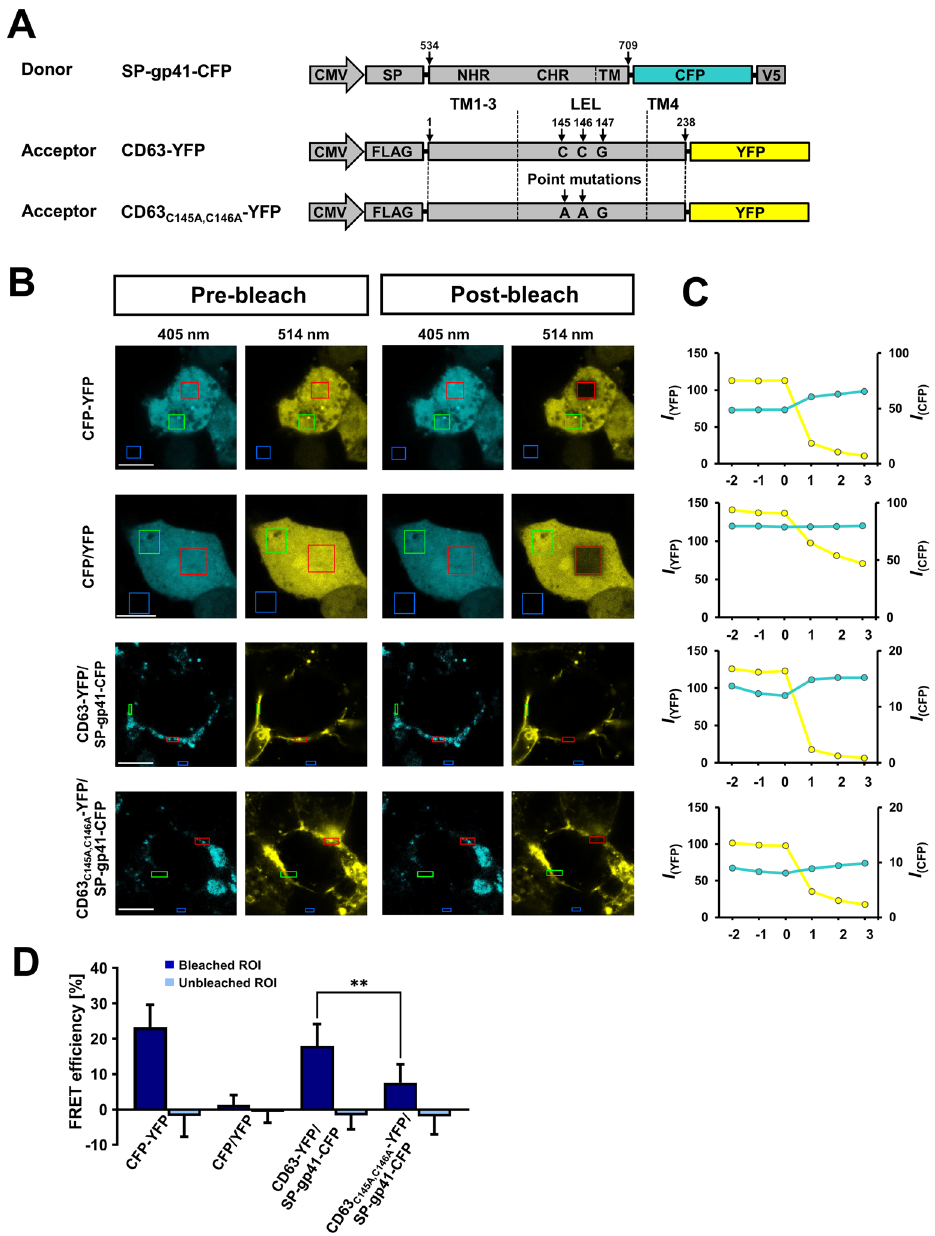
Figure 3. Detection of direct interactions between CD63 and gp41 by FRET. ( A ) Schematic representation of vectors used for the FRET experiments (not to scale), CMV: cytomegalovirus promoter, SP: sequence of yellow fluorescent protein, FLAG tag: DYKDDDDK, numbers refer to the amino acid sequence. ( B ) Confocal images of HEK293T cells expressing FRET pairs. Areas are marked by frames as regions of interest (ROIs) in red (bleached), green (unbleached) and blue (background) frames. ( C ) Fluorescence intensity ( I ) profiles of CFP (cyan line) and YFP (yellow line) emissions during acceptor photobleaching experiments. Acceptor photobleaching with a 514 nm laser line starts at time point 0 and is repeated at each further time point. ( D ) Quantification of FRET acceptor photobleaching experiments by calculating FRET efficiencies for CFP-YFP (n = 6), CFP/YFP (n = 6), CD63-YFP/SP-gp41-CFP (n = 9), and CD63 C145A,C146A -YFP/SP-gp41-CFP (n = 9). All scale bars: 10